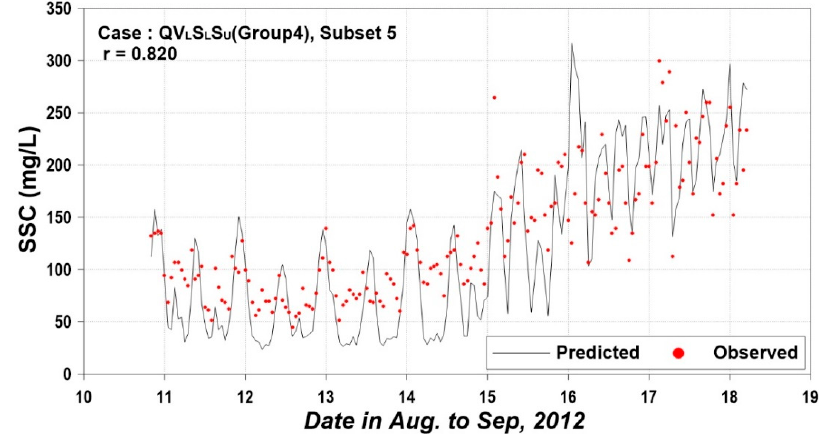
Figure 9. Time series of observed SSC (circle) and predicted SSC (solid line) in the prediction set. Input Case QV L S L S U and Subset 5 are used for the training, validation and